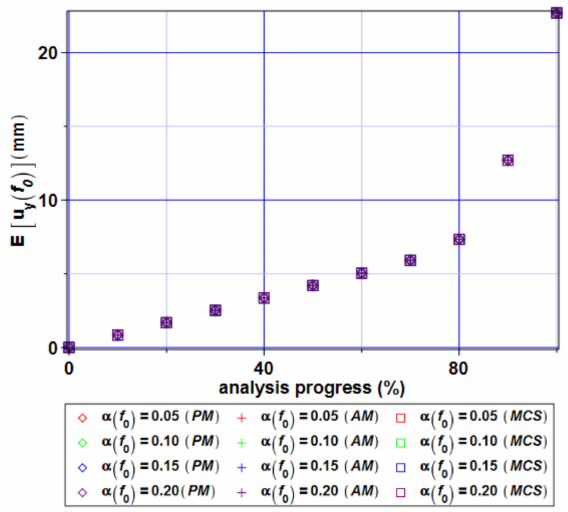
Figure 19. Expectations of the extreme vertical displacements E[u y (f 0 )] for the beam.